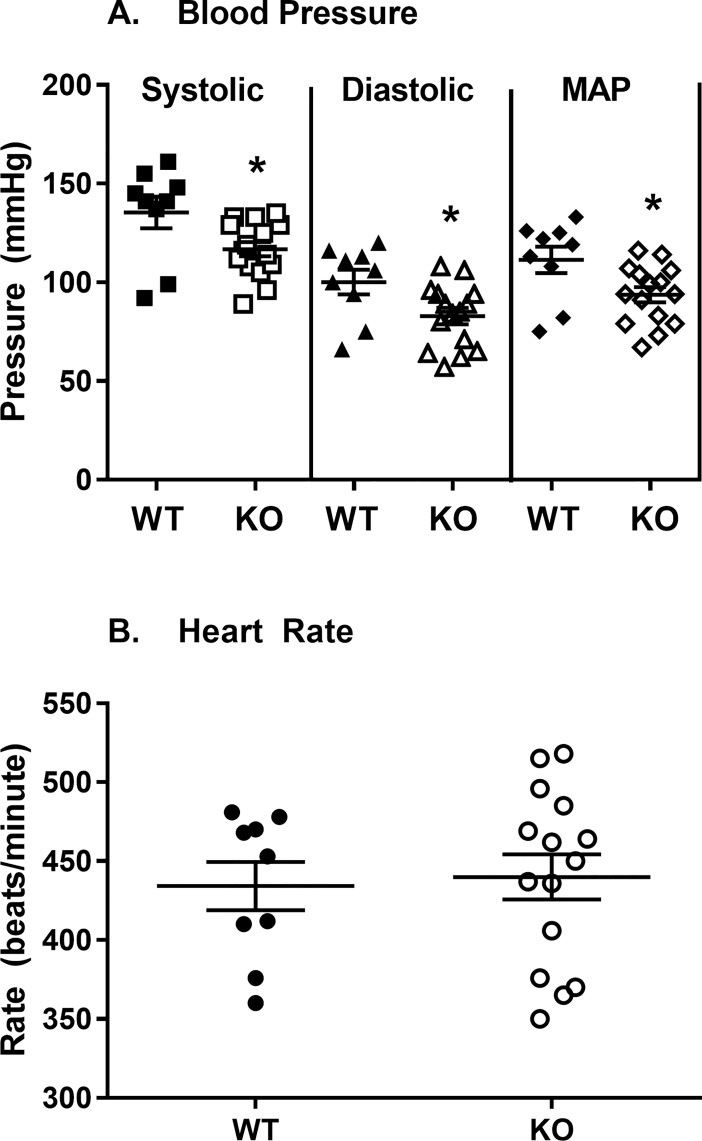
Haemodynamic measurements.Systolic, diastolic, mean arterial pressure (MAP) (Panel A), and heart rate (Panel B), were measured in anesthetized wild-type (WT) and Slc29a1-null (KO) mice using the tail-cuff method. *Significant difference between wild-type and Slc29a1-null mice for the indicated parameter (Student’s t-test for unpaired samples, two-tailed, P<0.05).